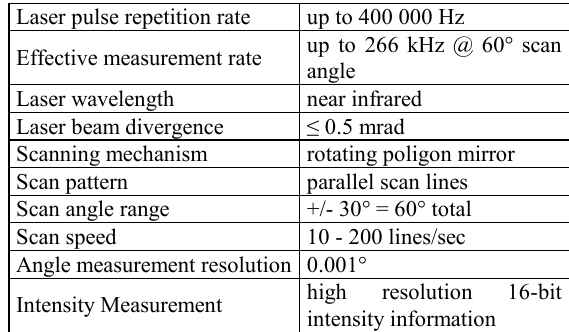
Table 1. Technical information of ‘Riegl LSM-Q680i’ laser